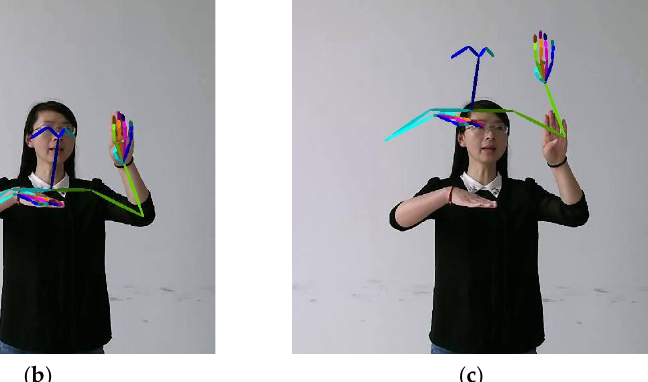
Figure 9. Keyframes of Chinese Sign Language word “Heavy”. Below the picture are the frame number and the values of image entropy. For example, 4-6.476 means the frame number is 4, and the image entropy is 6.476.